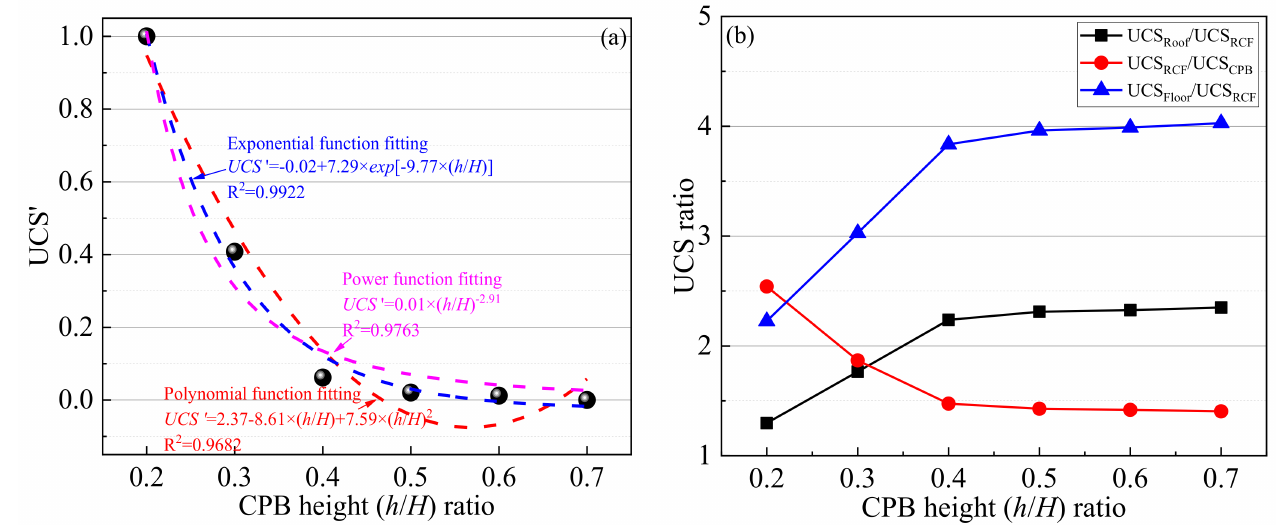
Figure 4. ( UCS of RCF material: ( a ) ( UCS and h / H ratio of RCF material; ( b ) ( UCS ratio and h / H ratio. The ( UCS ratios of the roof rock (RR) and floor rock (FR) to the RCF material repre- sents the ( UCS deterioration degree of the RCF material on the RR and FR,